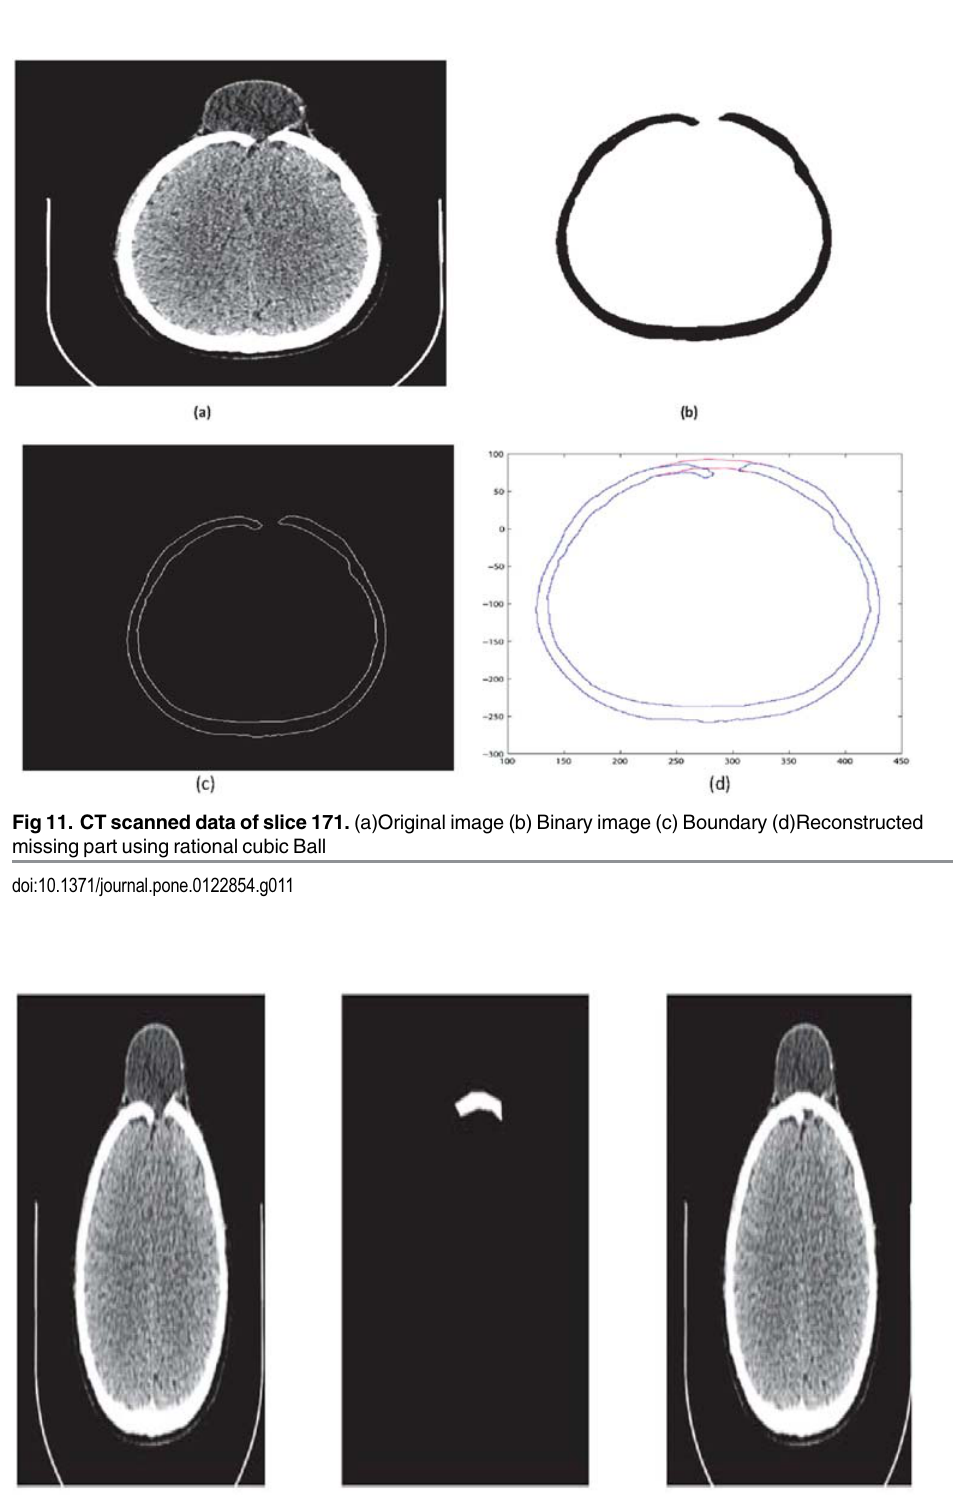
Fig 12. Missing data in Dicom format of slice